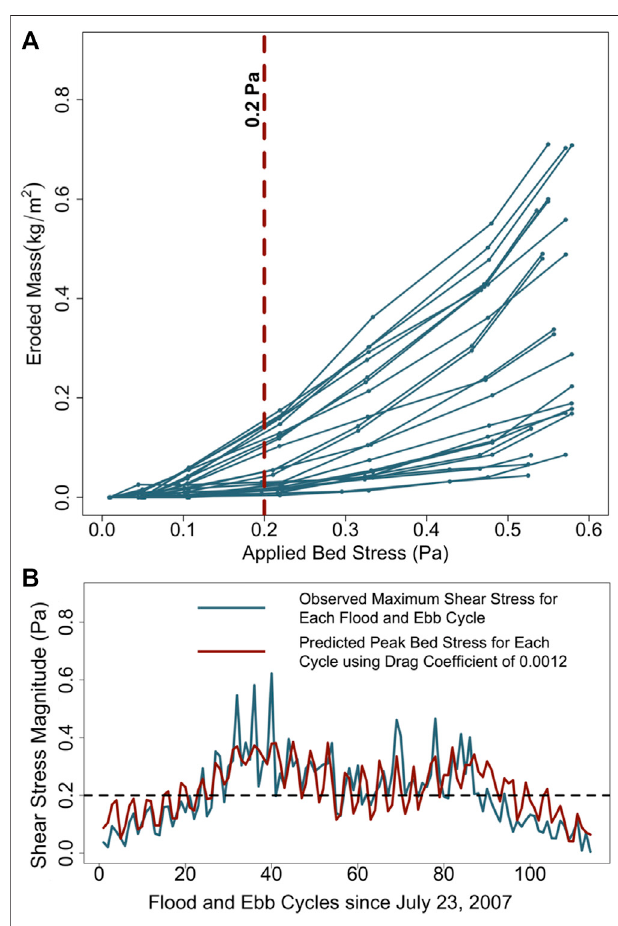
FIGURE 3 | (A) Examples of interpolation at 0.2 Pa of erosion curves from the Gust microcosm experiments. (B) Bottom shear stress observed in the Claybank region of the York River (Fall, 2012) along with bed stress estimated from τ b = C D U 2 , where U is cross-sectionally averaged tidal velocity amplitude (see Section Quantifying the Erodibility Pro fi le